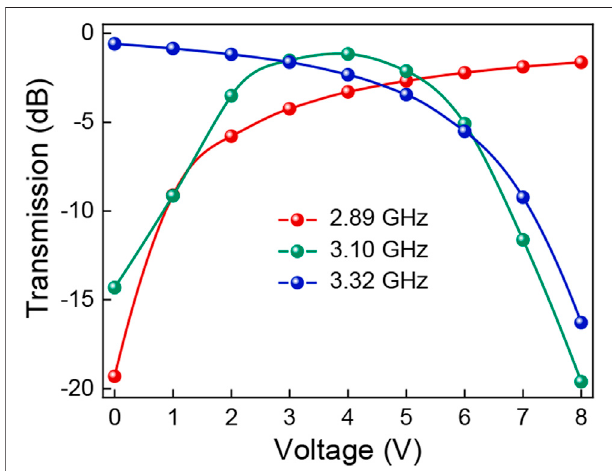
FIGURE 7 | Measured transmission of the metasurface with different bias voltages ranging from 0 to 8 V at 2.89 GHz (red), 3.10 GHz (green), and 3.32 GHz